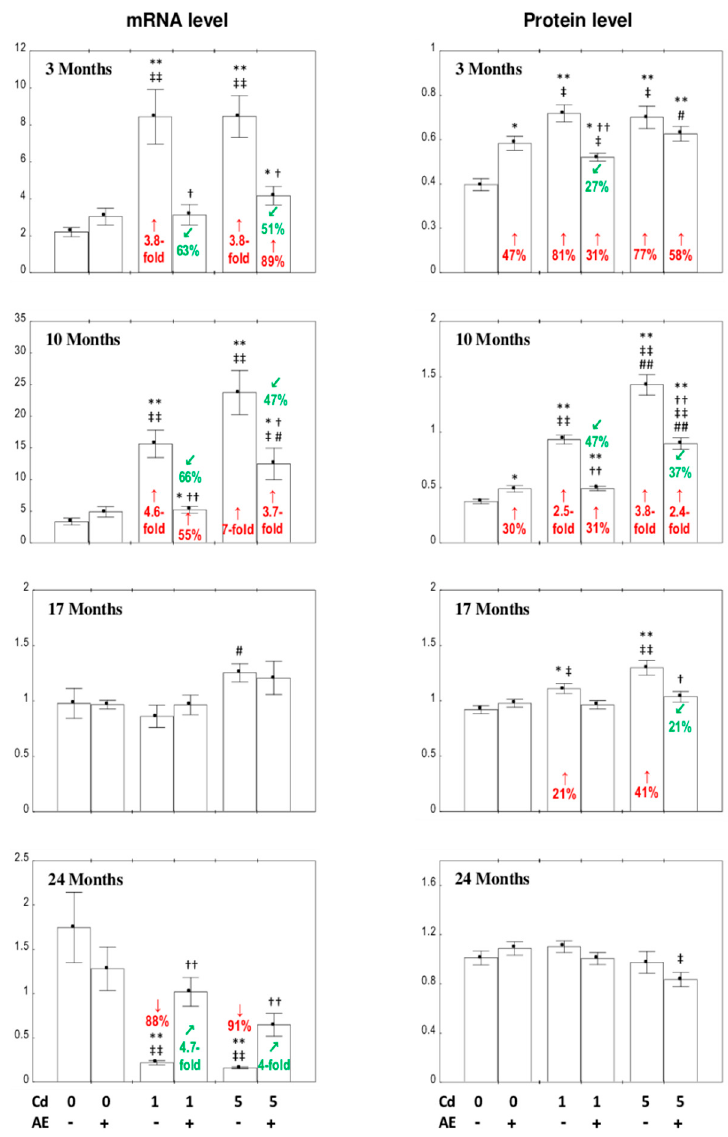
Figure 5. The impact of Aronia melanocarpa L. berry extract (AE) on the ratio of the expression of collagen type III to that of collagen type I at the mRNA and protein levels in the livers of rats exposed to cadmium (Cd). The animals were treated with Cd at the concentrations of 0, 1, and 5 mg Cd/kg in their diets and/or 0.1% aqueous AE (+) or not ( − ). Data are shown as mean ± SE for eight rats, except for seven animals in the AE, Cd 1 , and Cd 5 groups after 24 months. Statistically significant differences (Kruskal–Wallis post hoc test): * p < 0.05 and ** p < 0.01 vs. control group; † p < 0.05 and †† p < 0.01 vs. appropriate Cd group; ‡ p < 0.05 and ‡‡ p < 0.01 vs. AE group; # p < 0.05 and ## p < 0.01 vs. appropriate group maintained on the 1 mg Cd/kg diet (Cd 1 group or Cd 1 + AE group). Numerical values in bars (or above the bars) express the percentage changes or factors of changes in comparison to the control group ( ↑ , increase; ↓ , decrease) or the appropriate group exposed to Cd alone ( ↗ , increase; ↙ , decrease).